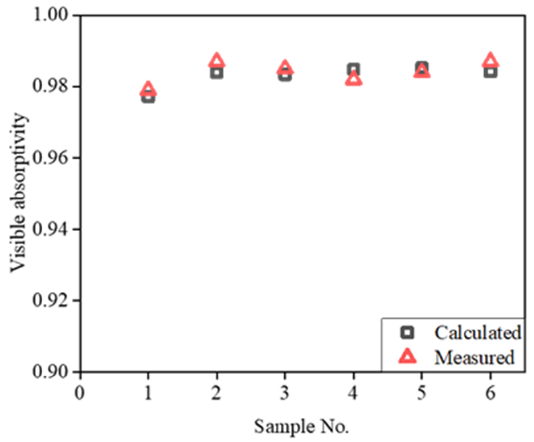
Figure 14. Calculated and measured values of visible-range absorptivity of various